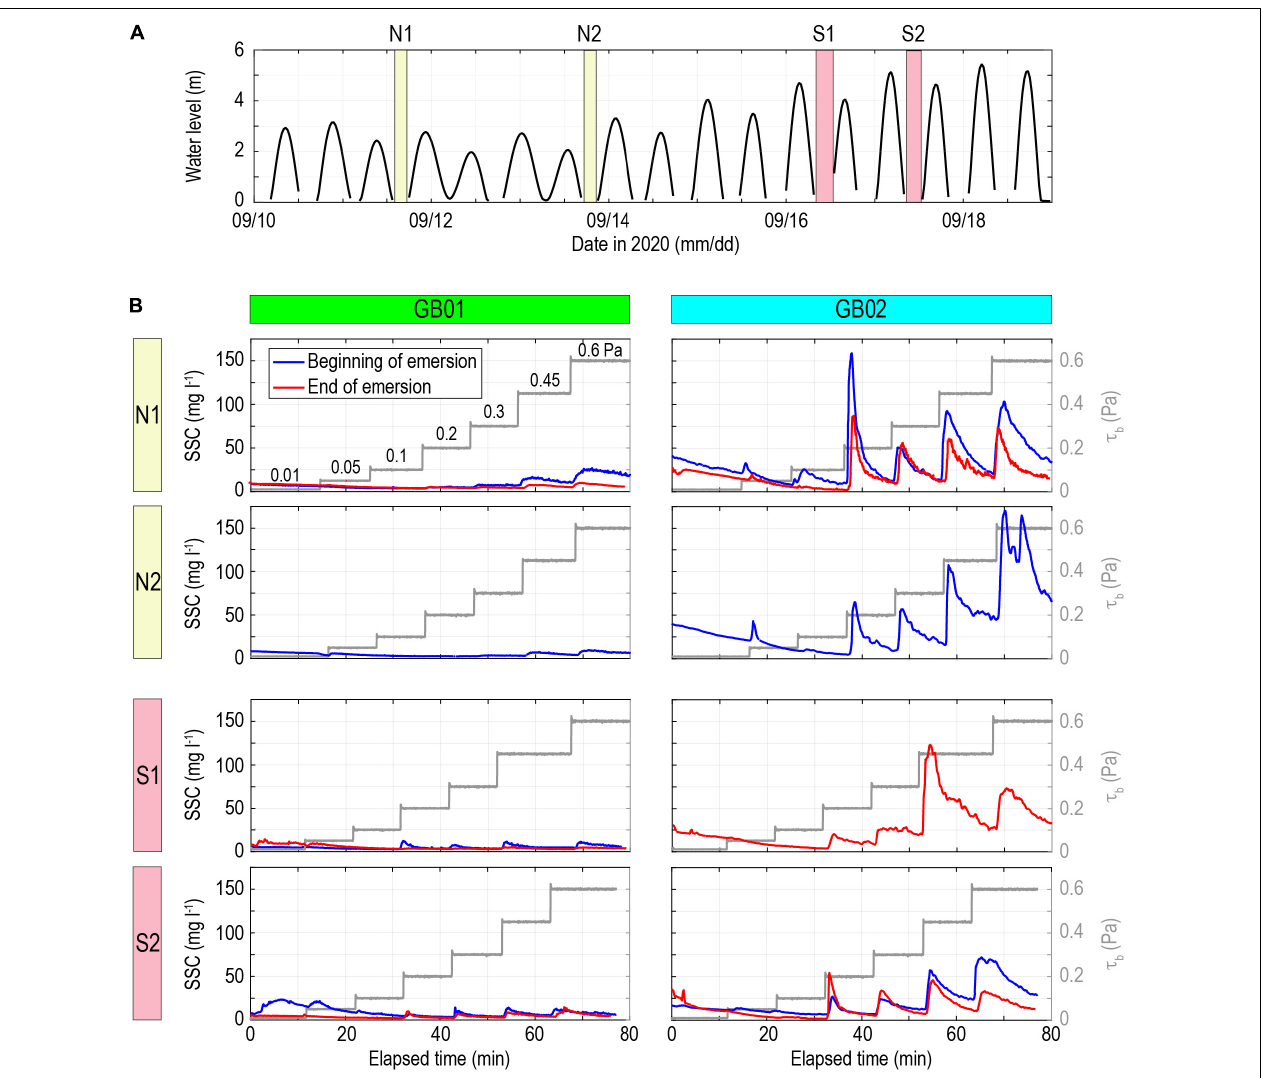
FIGURE 2 | (A) Time series of water level (m) at GB02. Pressure sensor (RBR SoloD) was deployed at 0.1 m above bed. Pressure data were converted to water level. The shaded areas indicate the sampling times at 09/11 (N1), 09/13 (N2), 09/16 (S1), and 09/17 (S2). (B) Results of GEMS experiments. Sediment cores were collected at the beginning (blue line) and the end (red line) of emersion. Seven steps of τ b (0.01–0.6 Pa) were applied for approximately 10 min per each